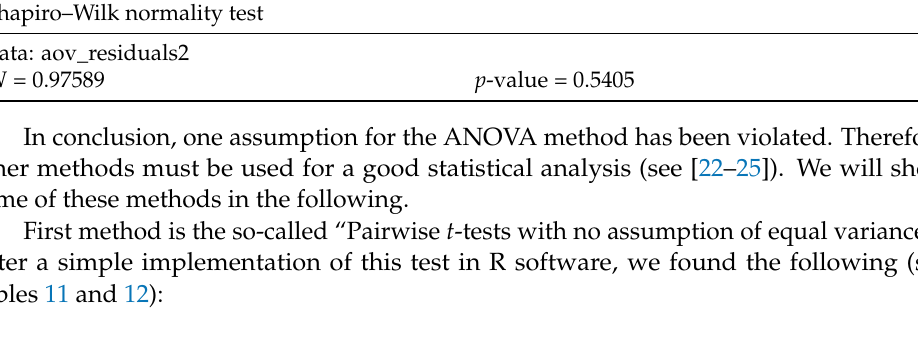
Table 11. Mean value and variance for NEXTDENT material.